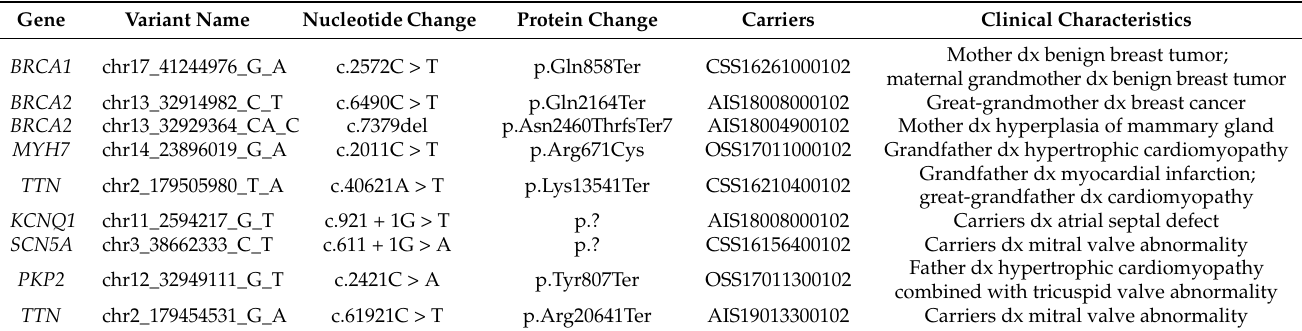
Table 1. Clinical characteristics of patients with